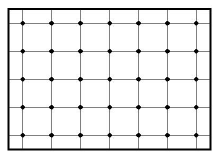
Figure 2: TE grid for the rectangular case.